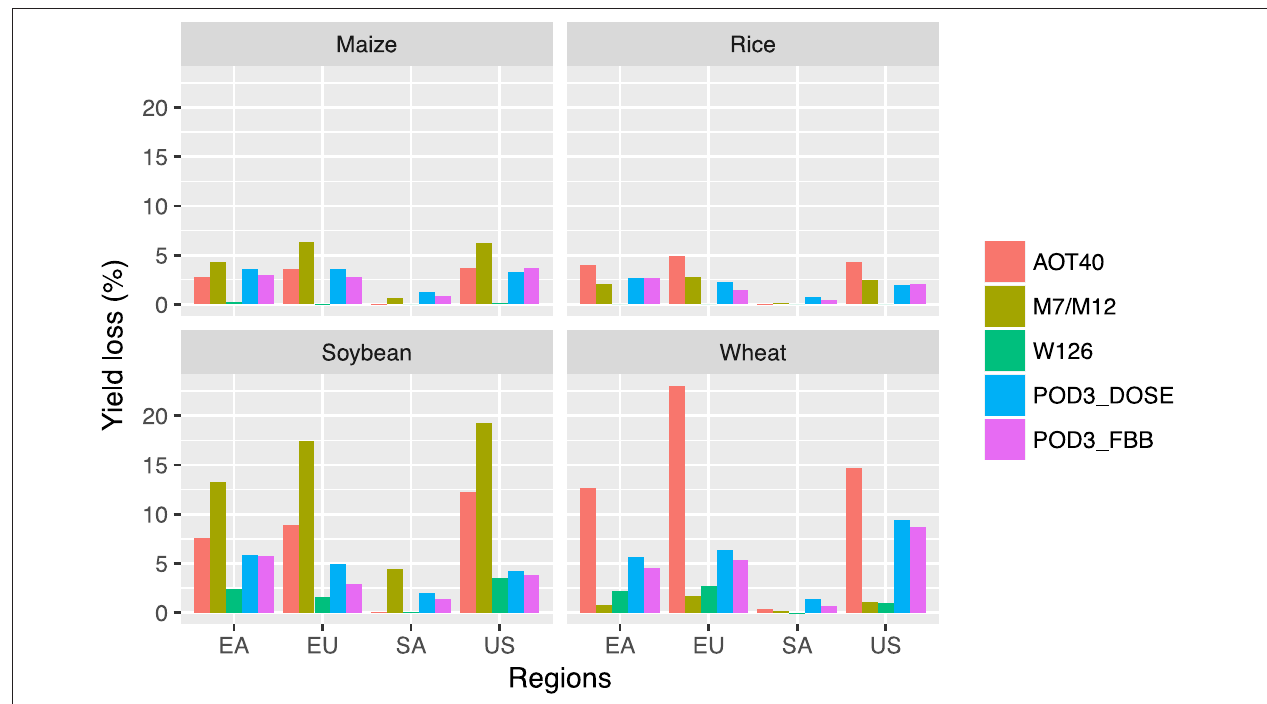
FIGURE 11 | Regionally aggregated yield losses (%) for maize, rice, soybean, and wheat, using different metrics. Four regions are East Asia (EA), Europe (EU), South America (SA), and United States